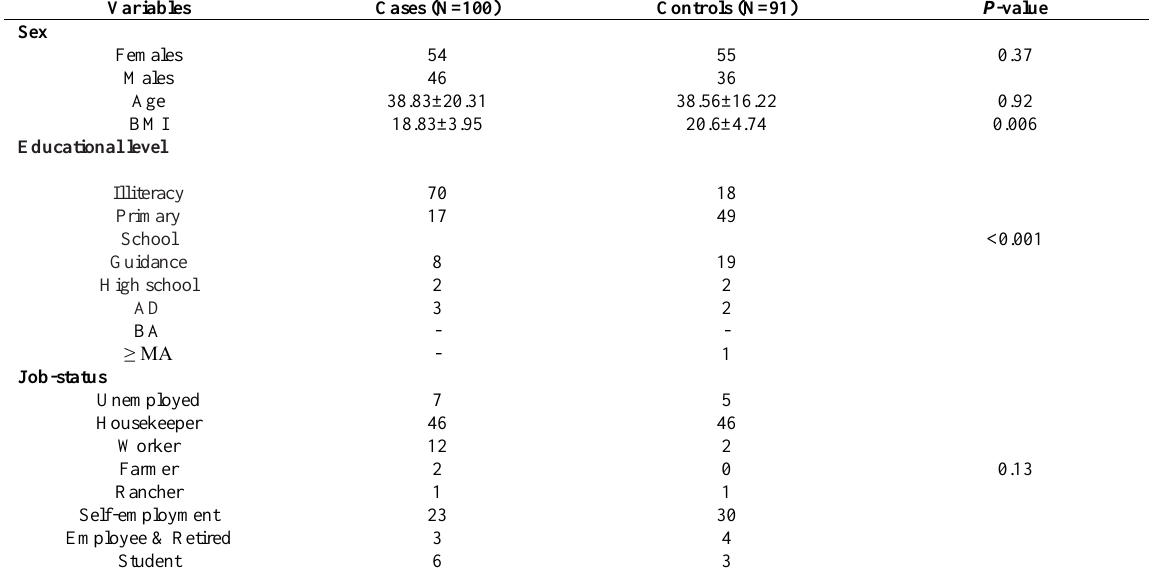
Table1 . The socio-demographic characteristics of the case and control groups.